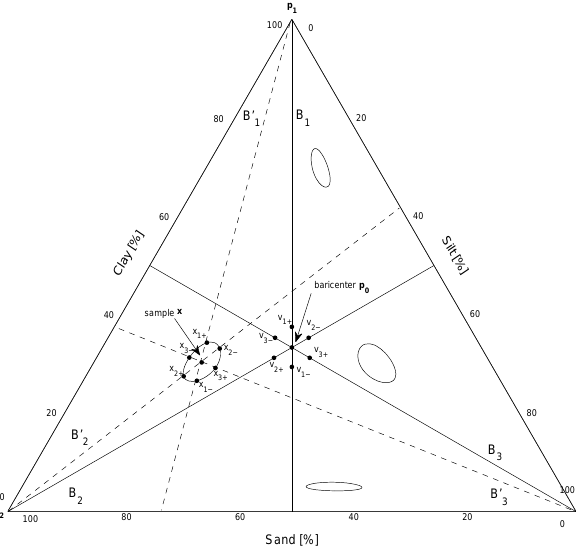
, B 0 and B 0 . 1 2 3